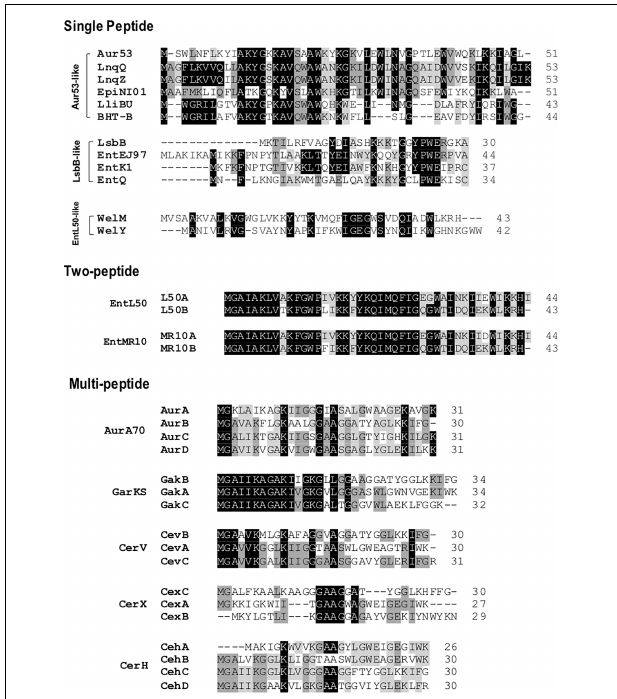
FIGURE 3 | Primary structures of leaderless bacteriocins. Leaderless bacteriocins are clustered based on the number of their component peptides; single-peptide, two-peptide, and multi-peptide. Single peptide group is composed of aureocin A53 (Aur53), lacticins Q and Z (LnqQ and Z), epidermicin NI01 (EpiNI01), lactolisterin BU (LliBU), BHT-B, LsbB, enterocins EJ97, K1, and Q (EntEJ97, EntK1, and EntQ, respectively), and weissellicins M and Y (WelM and Y). Two-peptide group is composed of enterocins L50 (L50A and B) and enterocins MR10 (EntMR10A and B). Whereas multi-peptide group is composed of aureocin A70 (AurA, B, C, and D), garvicin KS (GakA, B, and C), cereucin V (Cev A, B, and C), cereucin X (cexA, B, and C), and cereucin H (CehA, B, C, and D). Sub-clustering based on their sequence homology is also indicated; aur53-like, LsbB-like, and entL50-like. Intensity (black to gray) of the highlighted residue indicates strong conservation of their